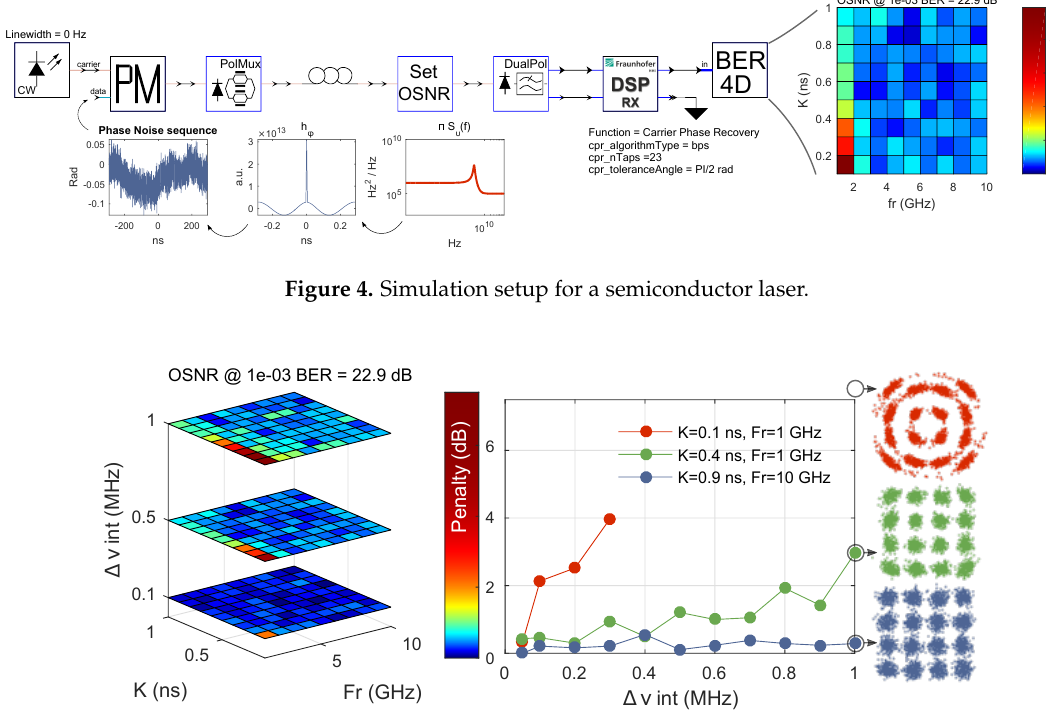
Figure 5. Simulation results for carrier induced frequency noise from transmitter